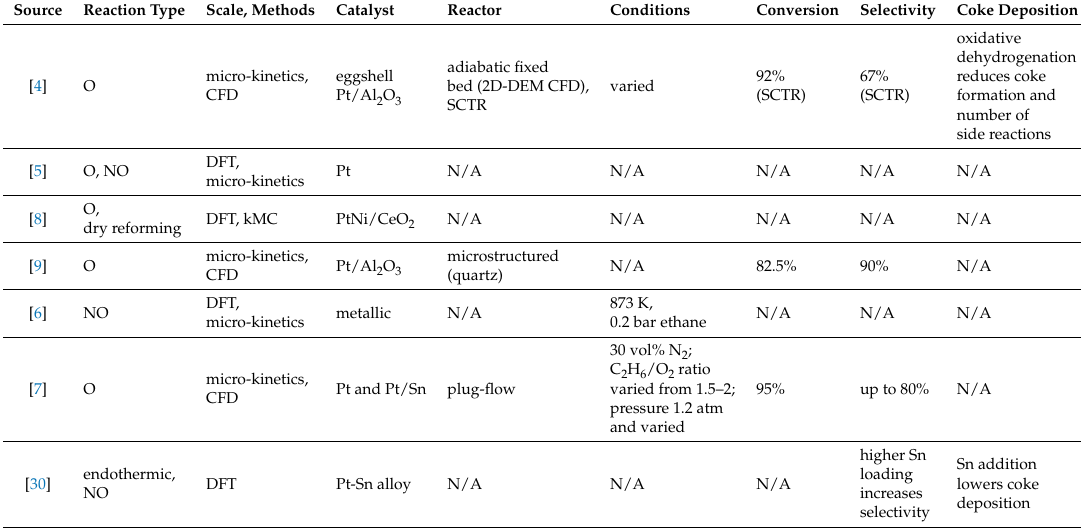
Table 1. The overview of the multiscale modeling results for ethane dehydrogenation process over different catalysts, reactor types, and conditions. Oxidative (O) and non-oxidative (NO) reaction types were